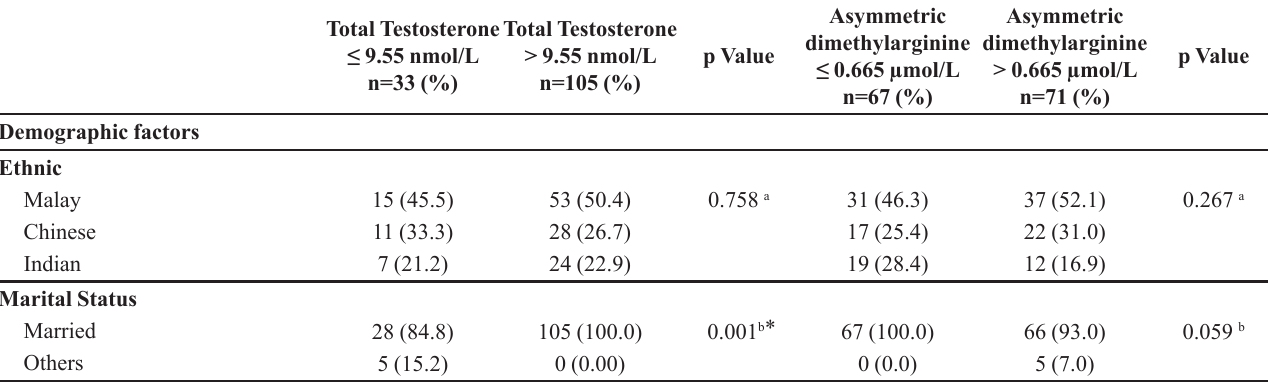
TABLE II - Association of Demographic, Clinical, and Lifestyle factors with Biomarkers level (TT and ADMA), n=